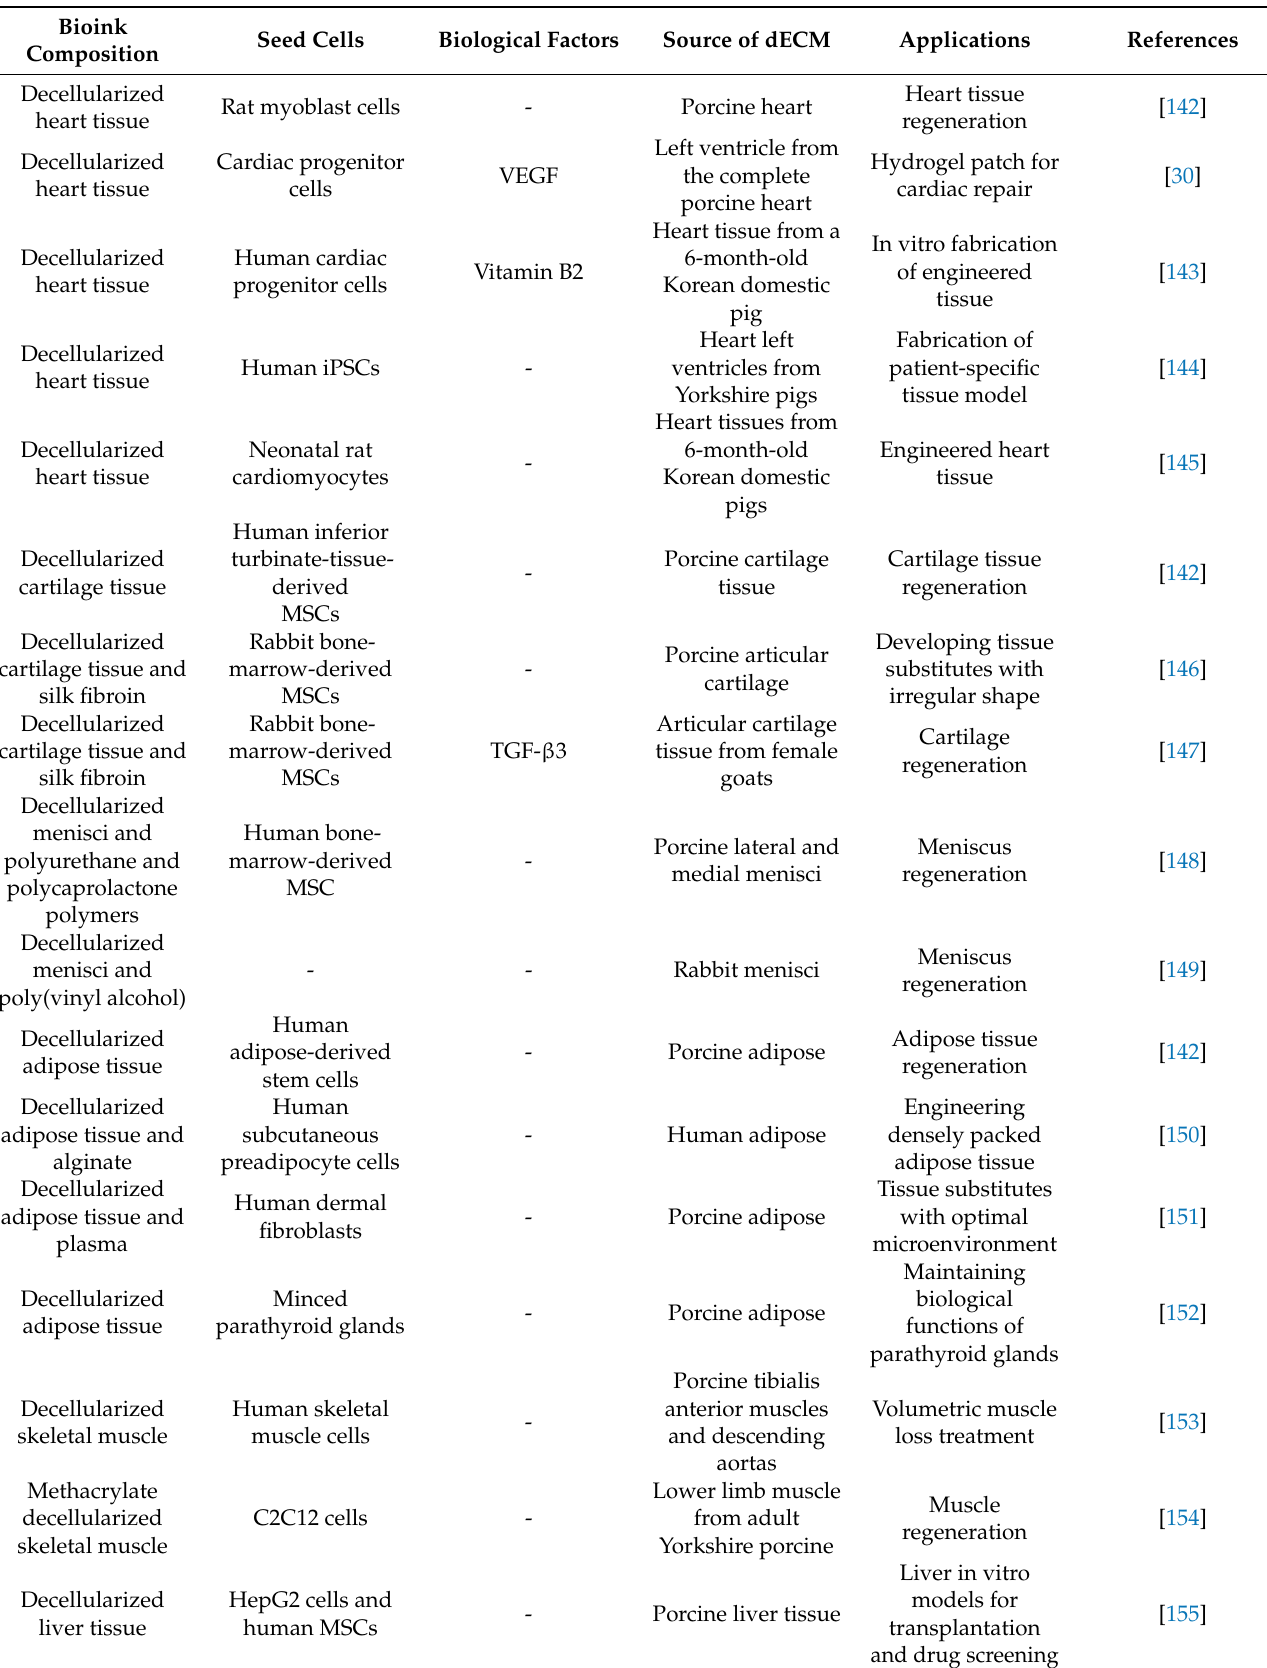
Table 1. The recent applications of dECM-based bioinks for bioprinting in tissue